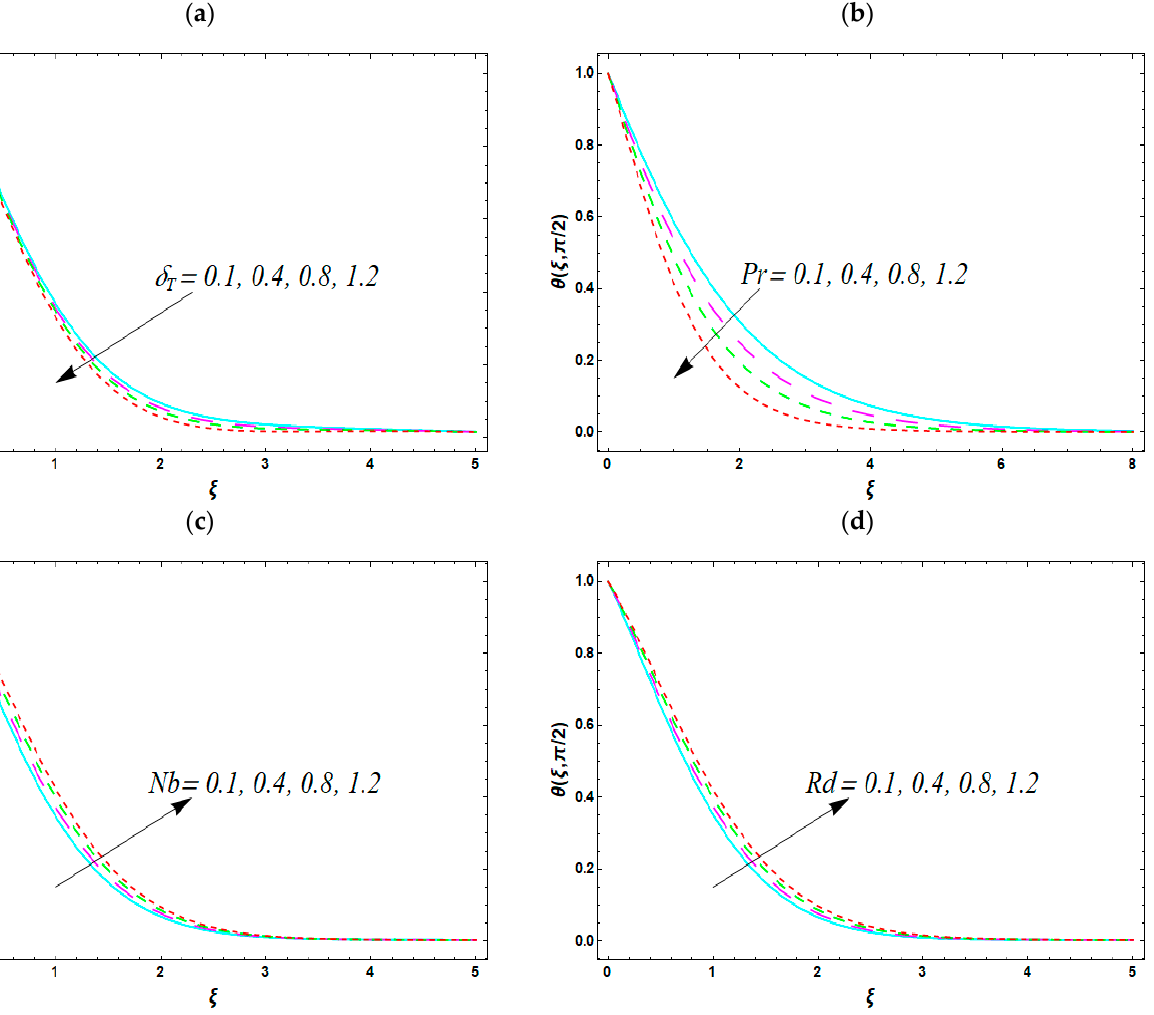
Figure 5. Temperature profiles for various values of ( a ) δ